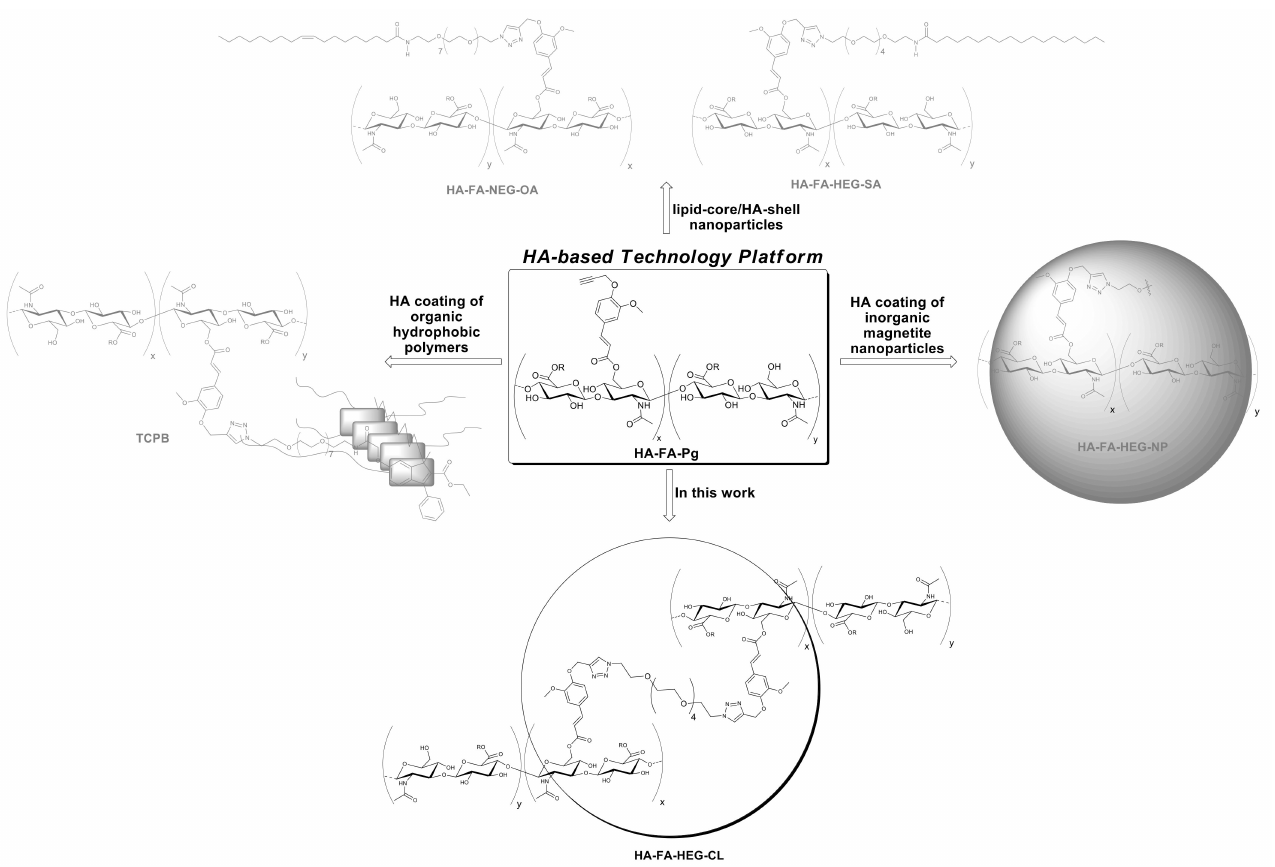
Figure 1. Development and applications of the HA -based technology platform employing HA-FA-Pg graft